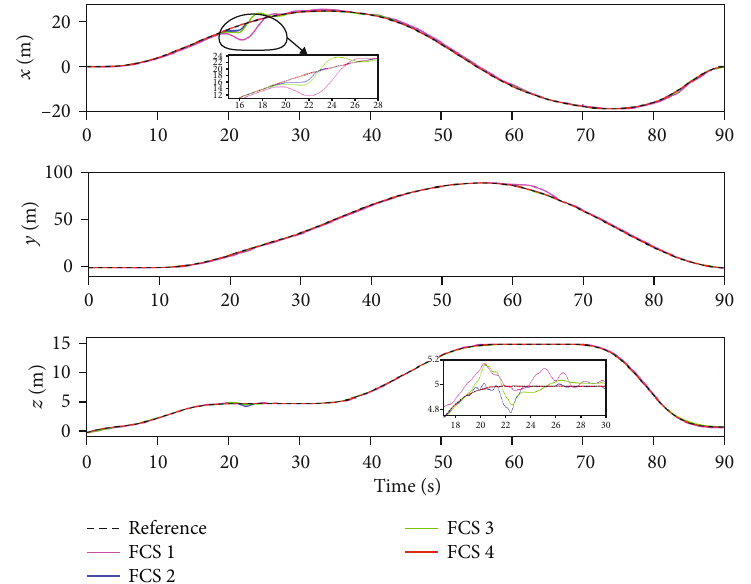
Figure 8: Pro fi les of the position of the quadrotor: translational variables ð x , y , z Þ : fl ight scenario